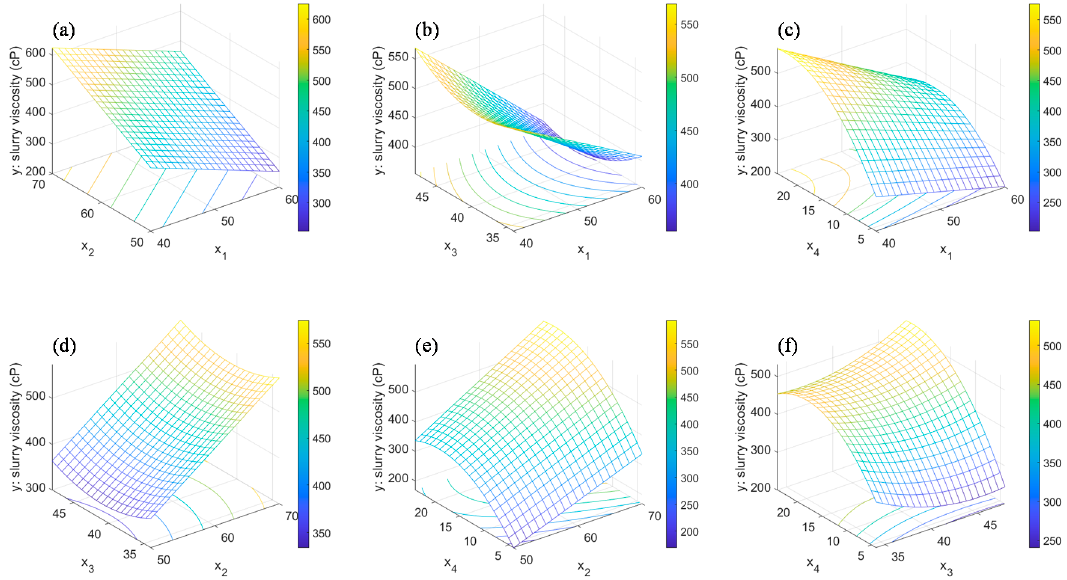
Figure 8. Response surface plots for Equation (9): ( a ) ( x 1 , x 2 , y ); ( b ) ( x 1 , x 3 , y ); ( c ) ( x 1 , x 4 , y ); ( d ) ( x 2 , x 3 , y ); ( e ) ( x 2 , x 4 , y ); ( f ) ( x 3 , x 4 , y ).